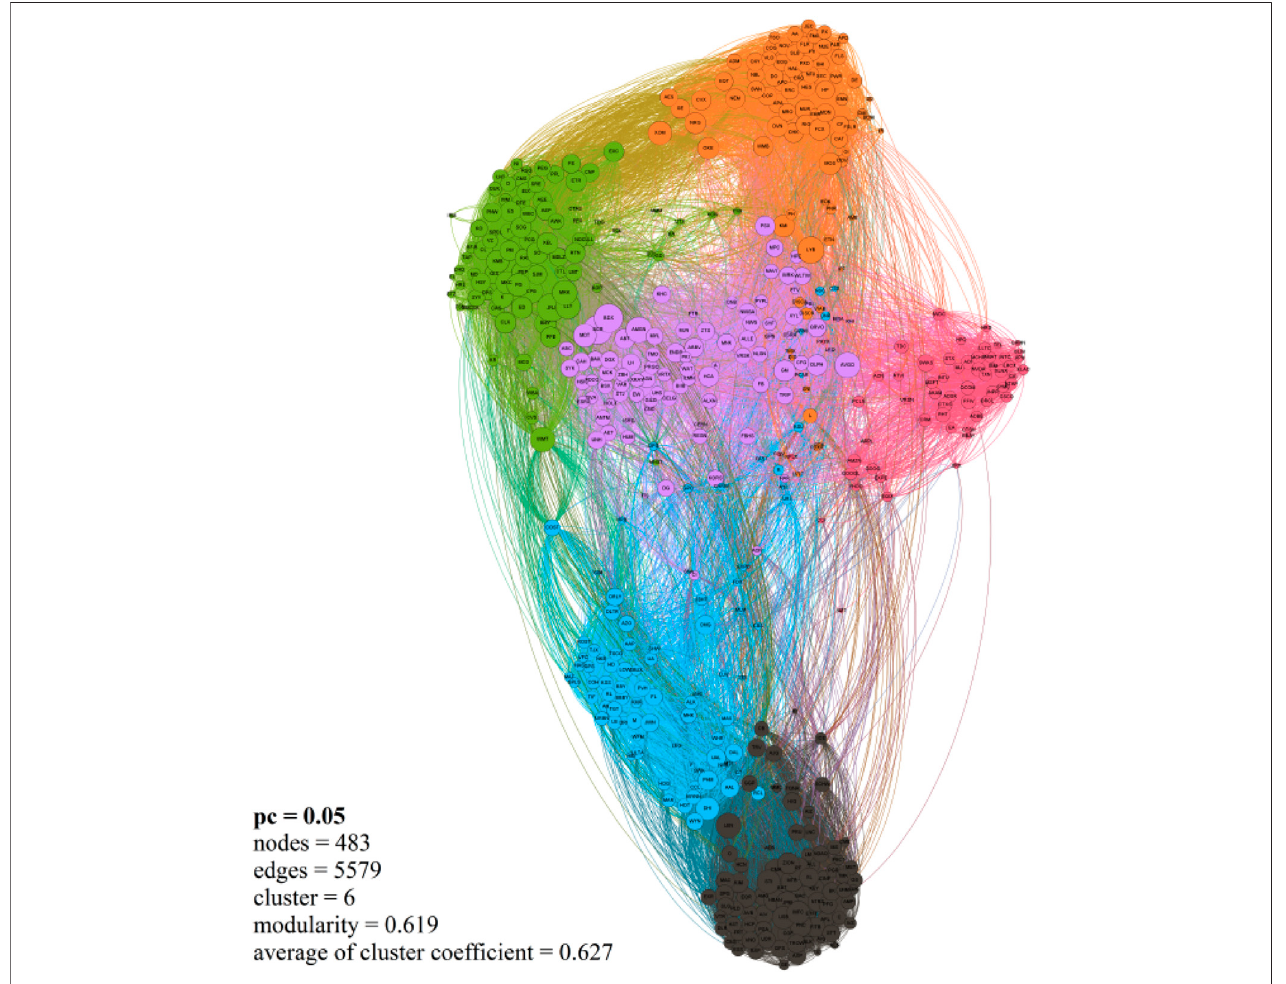
FIGURE 11 | The method successfully performs community detection. The S&P 500 stock market network using Gephi software, there are six main clusters, cluster 1 (black) is dominated by the fi nancial sector, cluster 2 (pink) is dominated by the information technology sector, cluster 3 (orange) is dominated by the energy sector, industrial and materials, cluster 4 (green) is dominated by the consumer staples, utilities, and industry sectors; cluster 5 (blue) is dominated by the consumer discretionary sector, and fi nally cluster 6 (purple) is dominated by the health care sector.